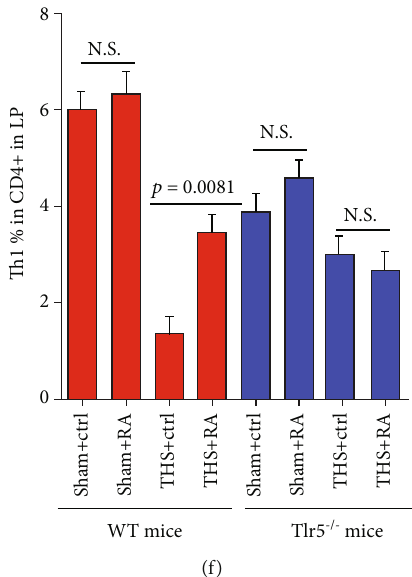
Figure 5: E ff ect of RA gavage on bacterial translocation in WT mice subjected to THS. Mice with or without RA treatment were sacri fi ced approximately 5 hours after C. rodentium challenge. Tissue samples were homogenized and cultured. Subsequently, bacterial abundance was calculated based on IVIS data. Samples were obtained from the MLNs (a), liver (b), blood (c), and spleen (d). Meanwhile, we determined the percentage of T 1 cells 48 hours after THS in the LP after RA treatment (e, f). Bacterial translocation data are expressed as median ± H interquartilerange . T 1 data are expressed as the mean ± SD , and each group contained 8 animals. All signi fi cant p values are marked, H and p < 0 : 05 is considered signi fi cant by the one-way ANOVA test. Data represent three independent